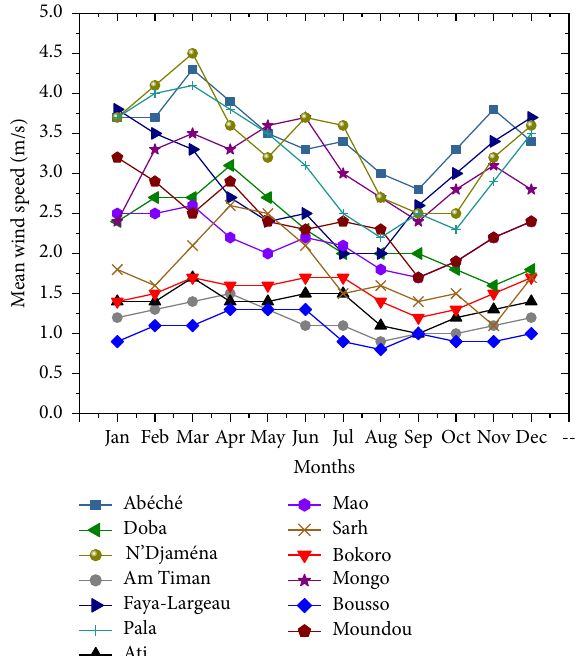
Figure 2: Monthly variation of wind speeds for all the selected sta-